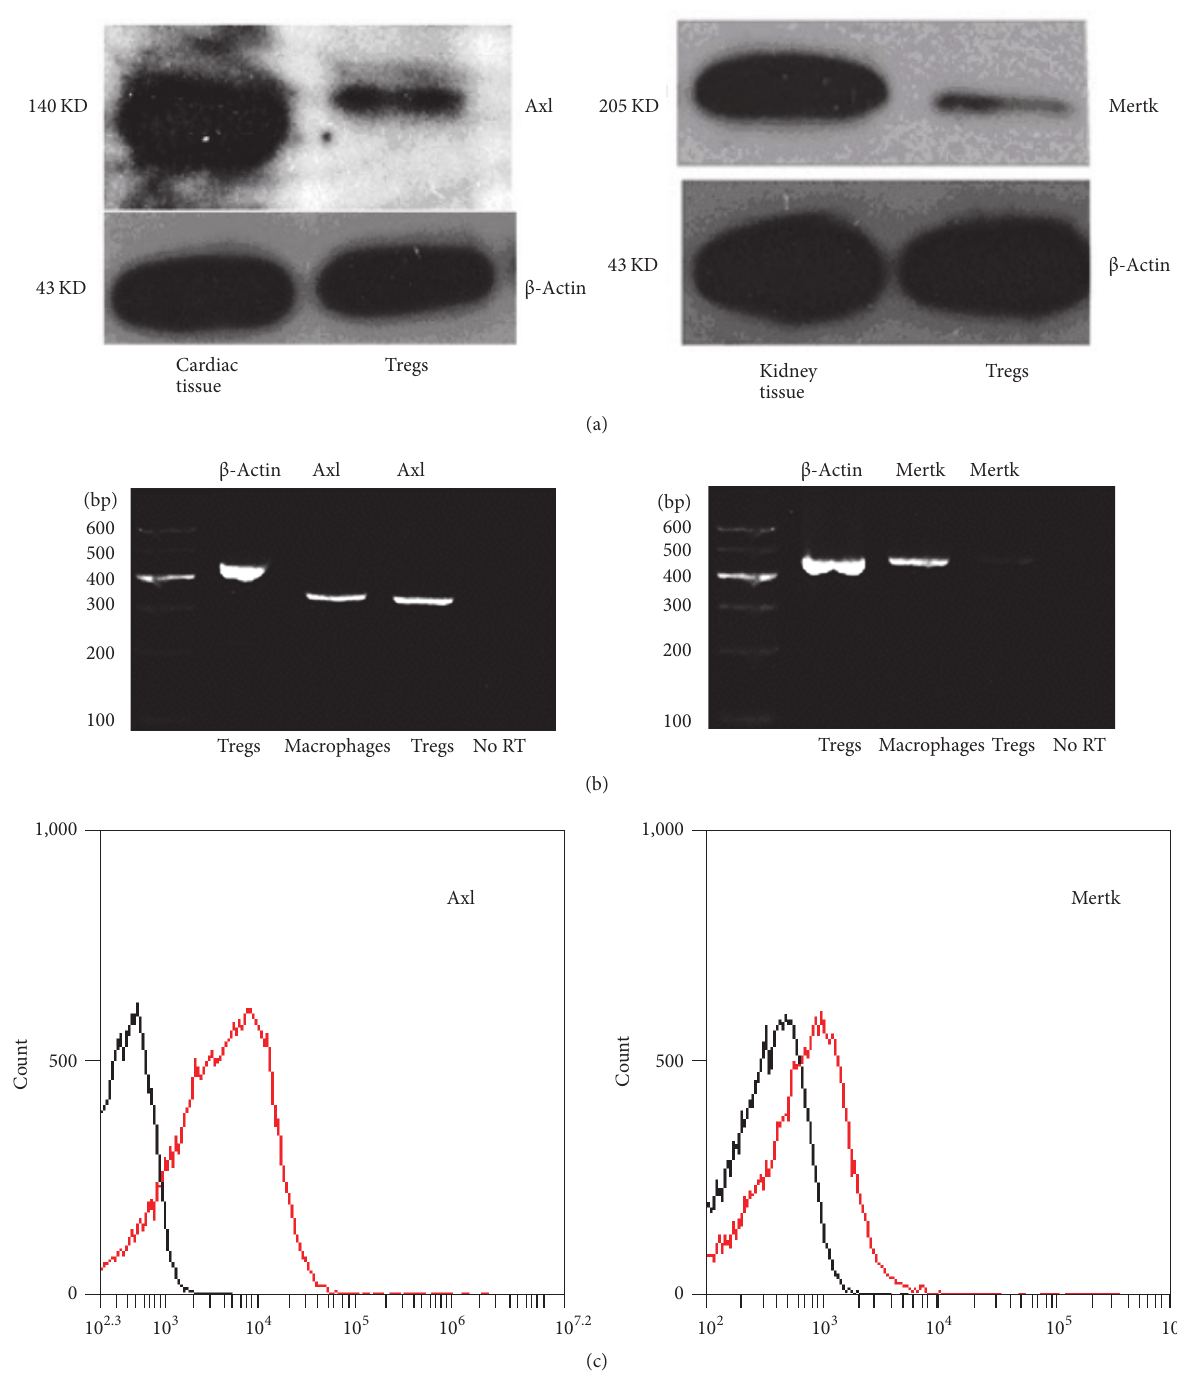
Figure 1: TAM receptors were expressed in mouse CD4 + CD25 + Tregs. (a) Protein expression from CD4 + CD25 + Tregs, cardiac tissue, and kidney tissue was analyzed by Western blot using specific anti-Axl (2 𝜇 g/ml) and anti-Mertk (2 𝜇 g/ml) antibodies. (b) Axl and Mertk mRNA expressions in CD4 + CD25 + Tregs and marcrophages were determined by semiquantitative RT-PCR. Expression of 𝛽 -actin was shown as an internal control. (c) CD4 + CD25 + Tregs were incubated with anti-Axl (10 𝜇 g/ml) and anti-Mertk (10 𝜇 g/ml) monoclonal Ab, respectively, followed by FITC-labeled goat anti-rat IgG as the secondary Ab (1:30). The cells were analyzed by flow